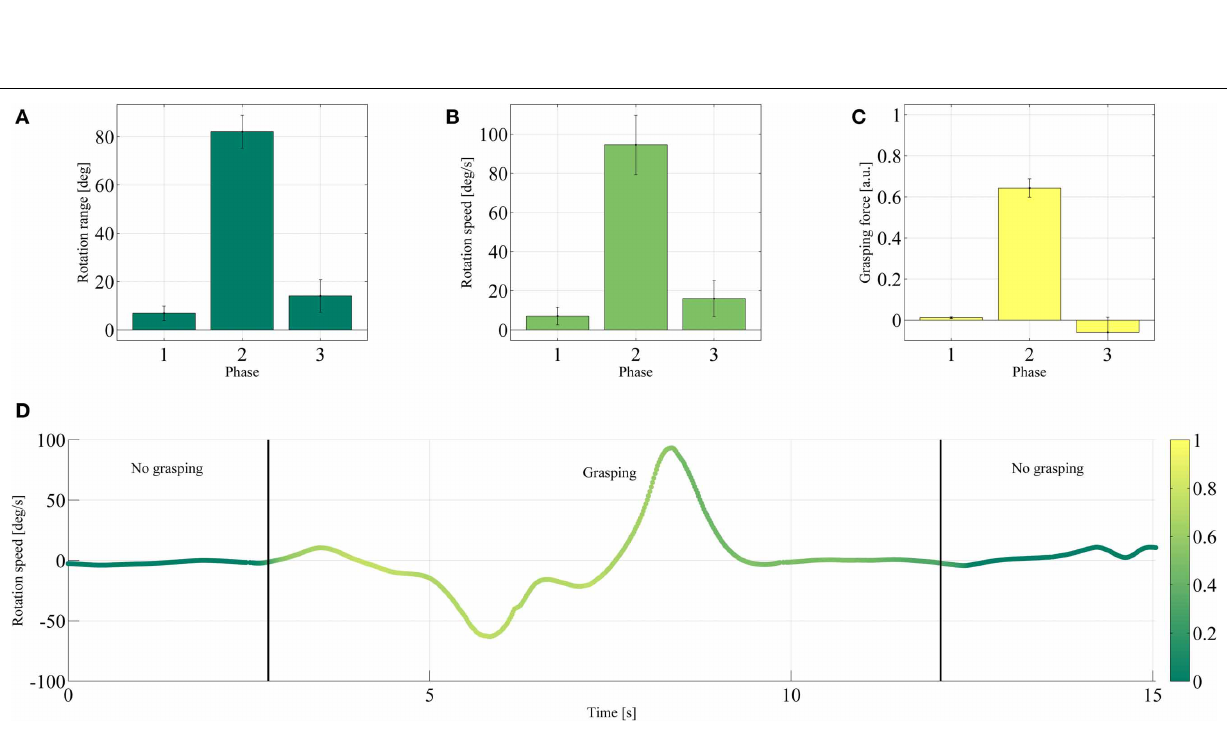
FIGURE 10 | Comparison of the wrist rotation range (A), wrist rotation speed (B), and grasping force (C) of the end effector during each phase of Task 2. The mean values and one standard deviation are reported over the